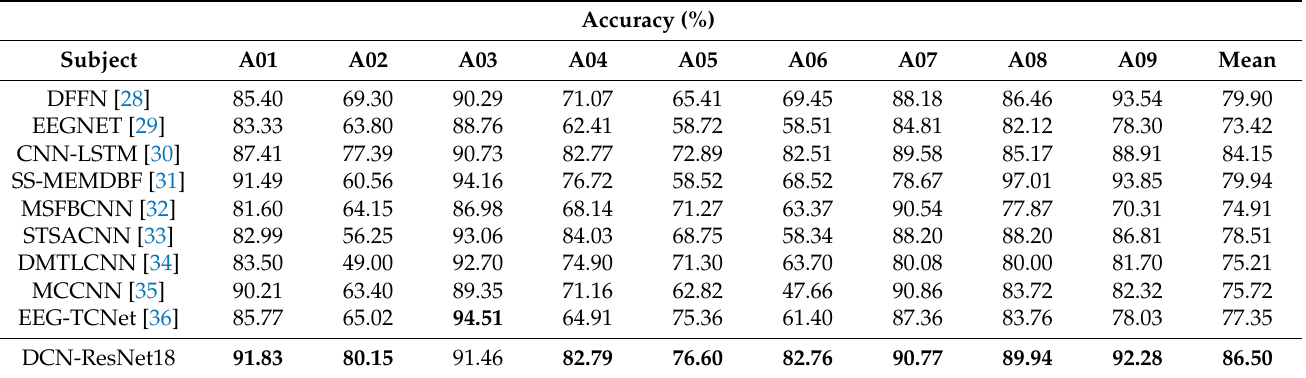
Table 7. Comparison of the recognition accuracy of different methods on BCIC IV dataset 2a